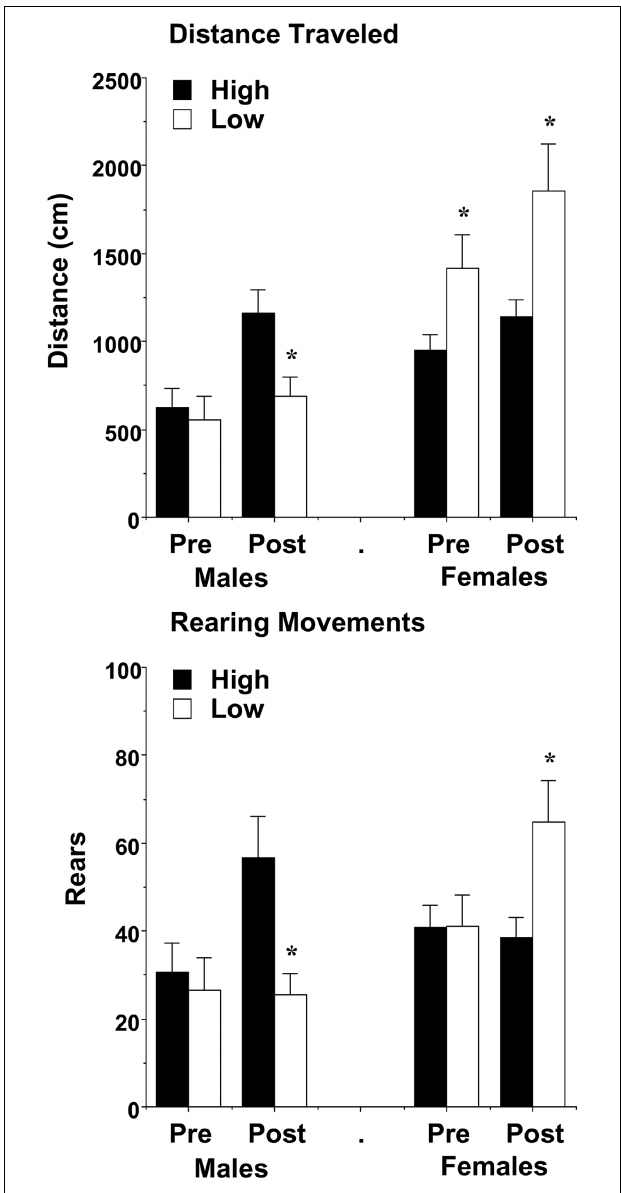
FIGURE 8 | Locomotion and vertical activity before and following exposure to an aversive stimulus (a saline injection). Data shown are means ( ± SEM) for the 10-min period pre- and post-injection. In comparison to offspring of dams with high levels of pup-licking, female offspring of low-licking dams had increased activity, while the male offspring had decreased activity, during the test. * p < 0.05.